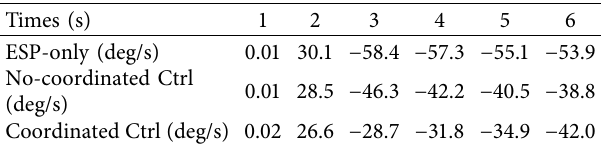
Table 6: Table of yaw rate with time in Fishhook test condition. Times (s) 1